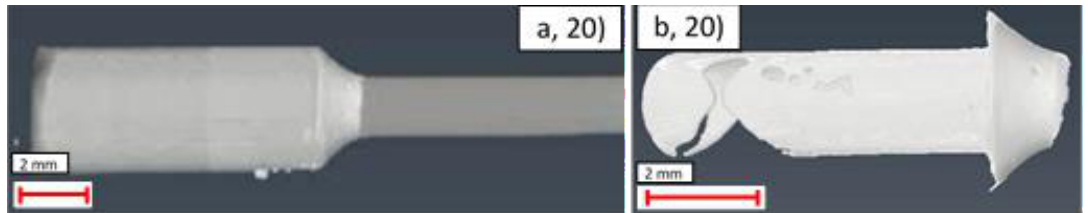
Figure 21. CT images of Ni-coated sample (20): ( a ) side view of pipe and gland exterior; ( b ) side view of left side interior solder.